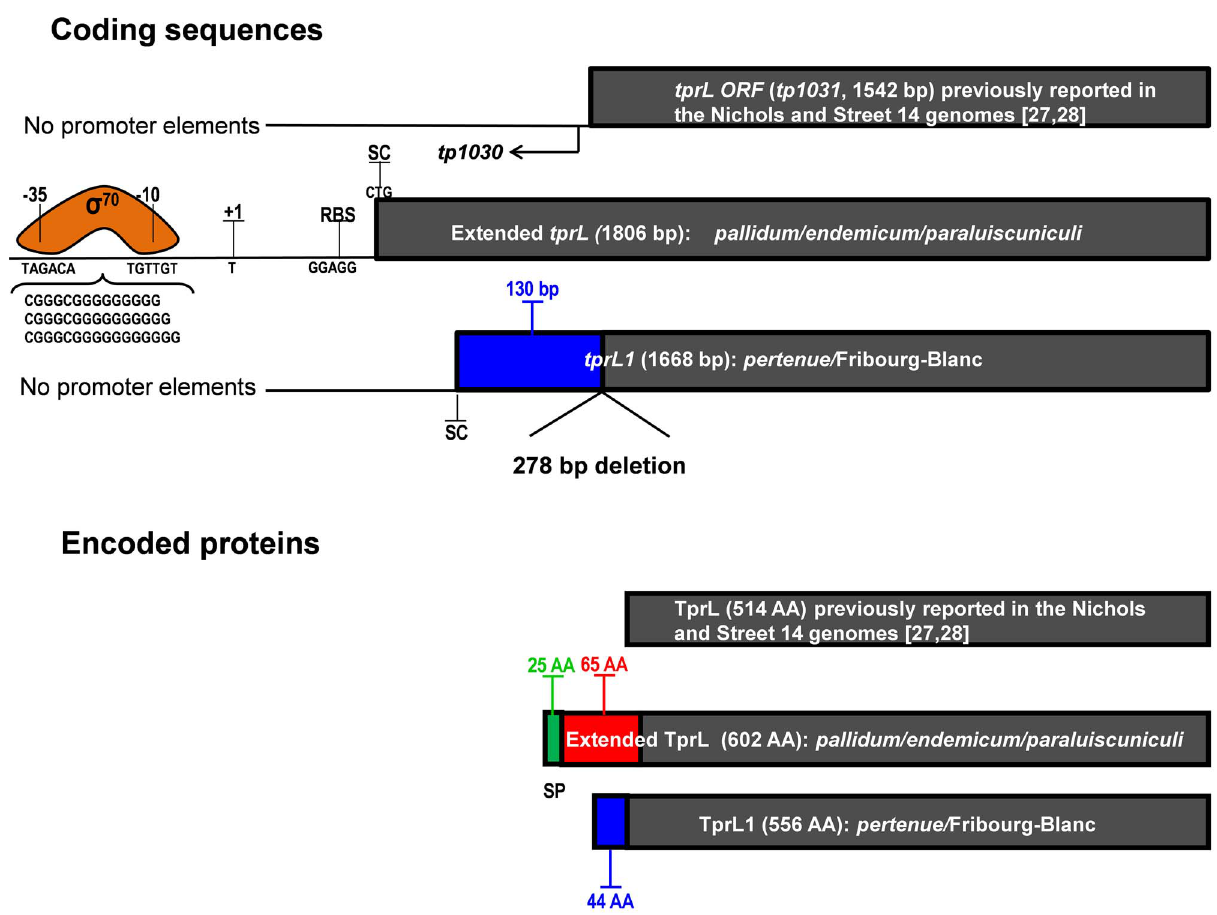
Figure 6. Encoded variants at the tprL ( tp1031 ) locus. Coding sequences: Three different coding sequences have been identified for treponemal species and subspecies: the proposed tprL ORFs in the Nichols and Street 14 genome sequences; an extended tprL for pallidum , endemicum , and paraluiscuniculi strains; and a fused tprL (called tprL1 ) for pertenue and the Fribourg-Blanc strains. The Nichols ORF was predicted to be 1542 bp, although lacks identifiable promoter elements upstream. In this study, an extended tprL of 1806 bp has been identified in the Nichols and other pallidum strains, as well as in endemicum and paraluiscuniculi strains. The initially shorter Nichols tprL was the result of sequencing errors in the reported Nichols genome sequence [27]. Typical promoter elements are shown for the extended tprL ORF (SC, start codon. RBS, ribosomal binding site. + 1, transcriptional start site (TSS). 2 10 and 2 35, s 70 signatures). A deletion of 278 bp (274 bp of the 5 9 end of tp1030 , whose coding sequence is located on the minus strand, and 4 bp of the 5 9 end of the genome-derived tprL ) creates an alternative start site in tp1030 for pertenue and Fribourg- Blanc tprL1 , resulting in a shorter ORF of 1668 base pairs. This ORF, however, lacks recognizable promoter elements. Encoded proteins: Differences in coding sequences result in two different proteins: 1) a shorter pertenue /Fribourg-Blanc variant with a 44 amino acid unique amino terminus and 2) a longer TprL in the remaining species/subspecies with a predicted signal peptide 25 amino acids long (green) in the longer product, but not identifiable in the pertenue /Fribourg-Blanc gene product. Blue color, region unique to pertenue and Fribourg-Blanc strains (132 nucleotides or 44 amino acids). Red color, region unique to the pallidum , endemicum and paraluiscuniculi species/subspecies (65 amino acids).